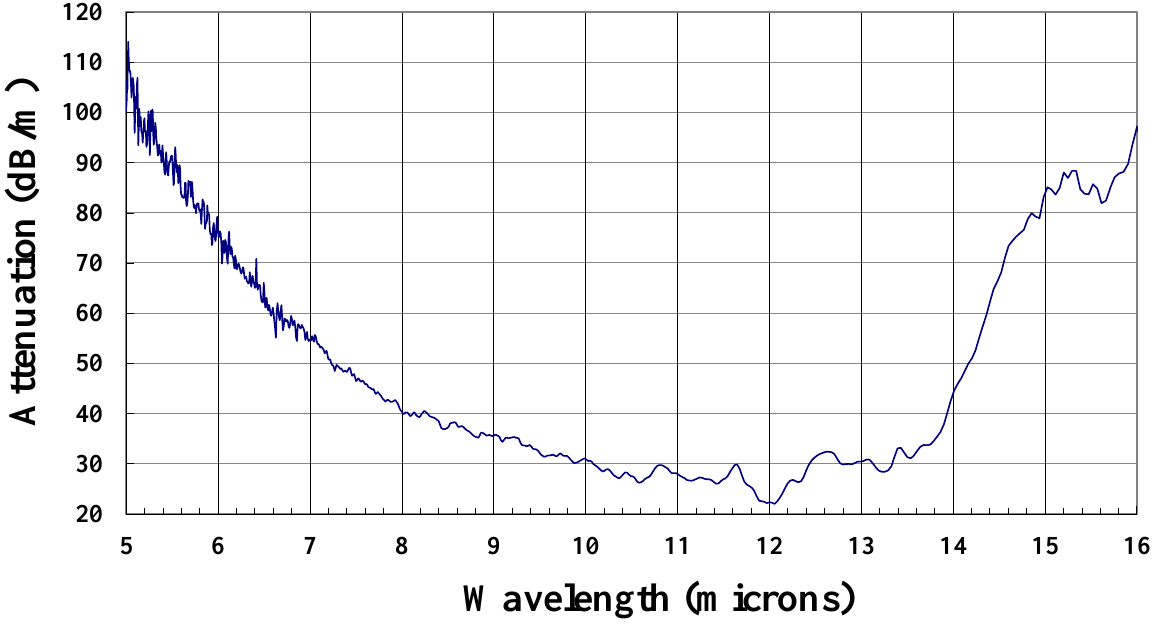
Figure 2. Attenuation curve of a Ge 12